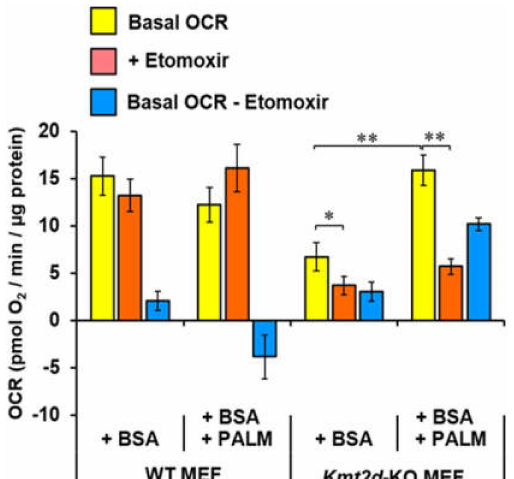
Figure 8. Fatty acids-related respiratory activity of Kmt2d -KO and WT MEF. Cells were assessed for resting OCR. Medium was supplemented with bovine serum albumin ( + BSA) or with BSA + palmitate ( + BSA + PALM); etomoxir was added to inhibit long-chain fatty acid oxidation. Bars are means ± SEM of n = 3 independent biological replicates in triplicate; *, P < 0.05; **, P <